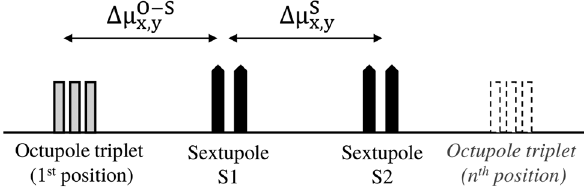
FIG. 1. Schematic of the octupole triplet position scan. Δ μ O − S x;y is the phase advance between the octupole triplet and the first sextupole. Δ μ S x;y is the phase advance between the sextupoles and is equal to ð 2 n þ 1 Þ π . Fig. 1, with the same β -function conditions and thus with ⃗ k the same strength for an exact cancellation of ⃗ α . For oct each location, all RDTs are recalculated at the end of the optics sequence. This scan shows the impact of octupole triplet positions, when powered for the same correction of